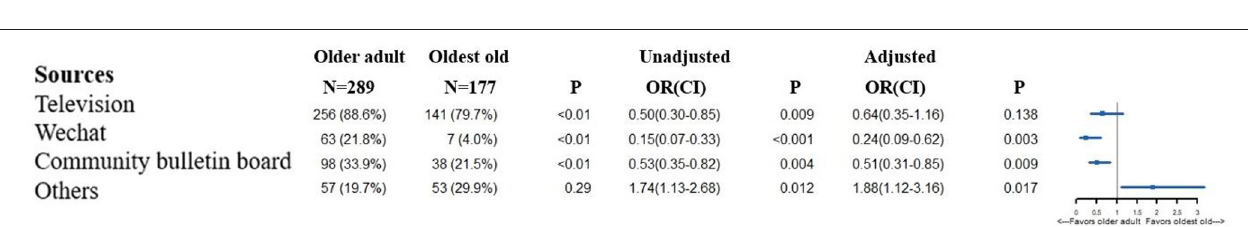
FIGURE 5 | Differences in the awareness of stroke-related knowledge between older adults and the oldest old (age cut-off 75 years). OR, Odds Ratio; CI, Confidence Interval; EMS, emergency medical service. Acute stroke therapy included thrombolytic therapy and endovascular therapy. Stroke educational tools included FAST and Stroke 1-2-0. In the multivariable logistic regression analysis, we adjusted gender, educational background, smoking history, drinking habit, hypertension, diabetes, myocardial infarction, prior stroke, dyslipidemia, cancer history, atrial fibrillation. The OR means the comparison between the older adults and oldest old (oldest old vs. the older adults).